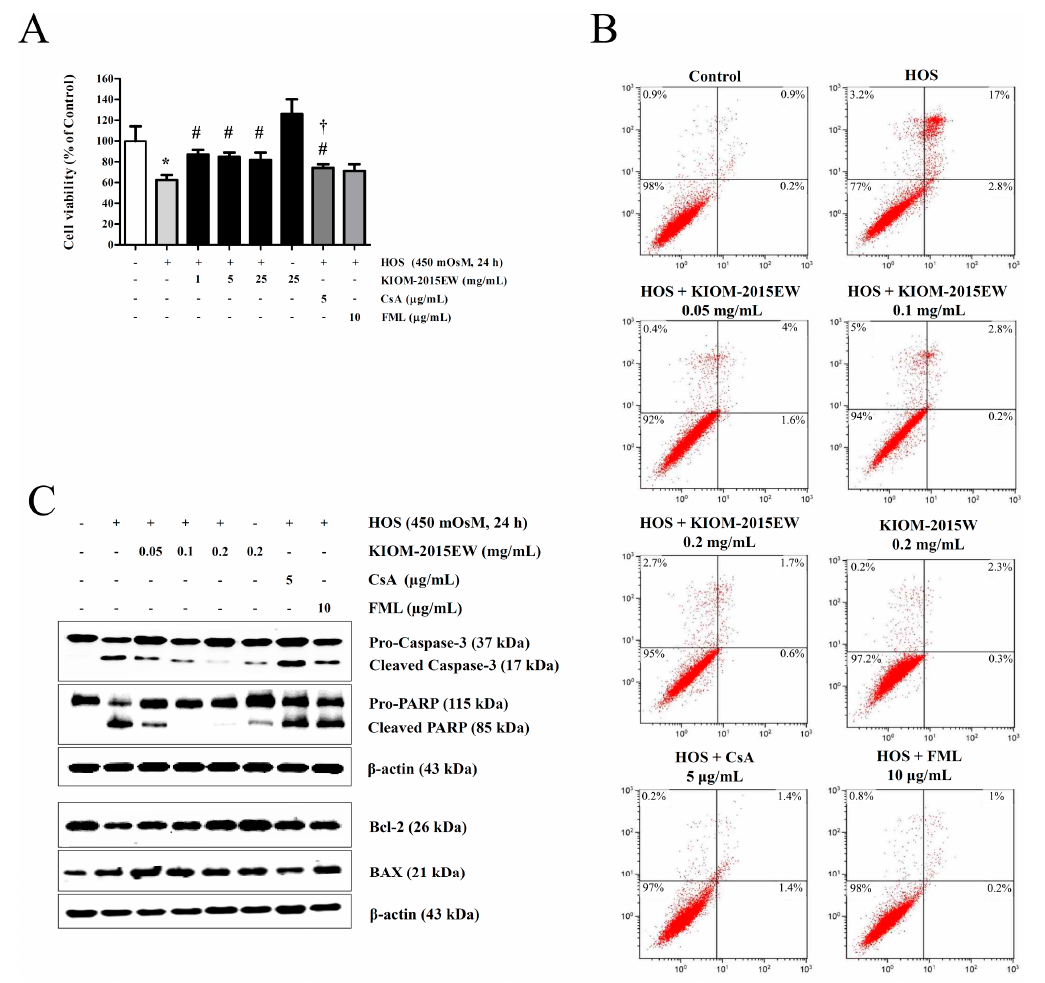
Figure 3. The anti-apoptotic effect of KIOM-2015EW in HOS-induced cell cytotoxicity. HOS-exposed HCECs were treated with KIOM-2015EW for 24 h. CsA and FML were used as positive anti-inflammatory drugs. ( A ) Cell viability was measured by MTT assay; ( B ) After incubation with KIOM-2015EW for 24 h, apoptotic HCECs were stained with Annexin V and propidium iodide (PI) and analyzed by flow cytometry. Cells are represented in the dot plot as healthy (Annexin-V − /PI − , lower-left quadrant), early apoptosis (Annexin-V+/PI − , lower-right quadrant), late apoptosis (Annexin-V+/PI+, upper-right quadrant), and necrosis (Annexin-V − /PI+, upper-left quadrant); ( C ) Expression levels of apoptosis-related markers, including caspase-3, poly (ADP-ribose) polymerase (PARP), Bax, and Bcl-2, were determined by western blot analysis. β -Actin was used as the loading control. The data are presented as the mean ± SD of three independent experiments. * p < 0.05 vs. control, # p < 0.05 vs. HOS, † p < 0.05 vs. KIOM-2015EW (25 µ g/mL). The full size blot is shown in Supplementary Figure S2.